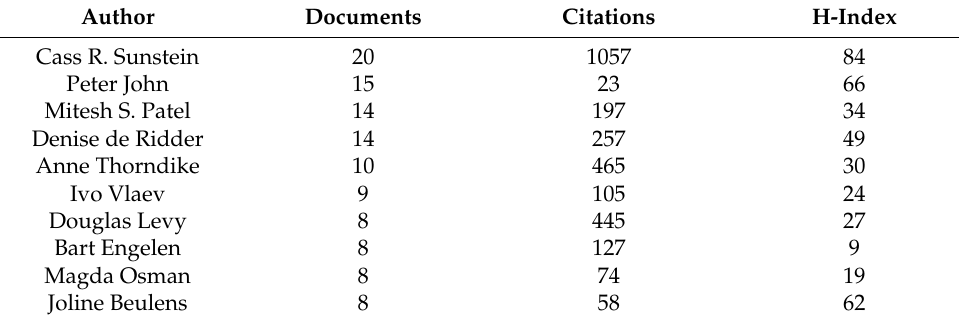
Table 5. Prominent authors by documents and citations.